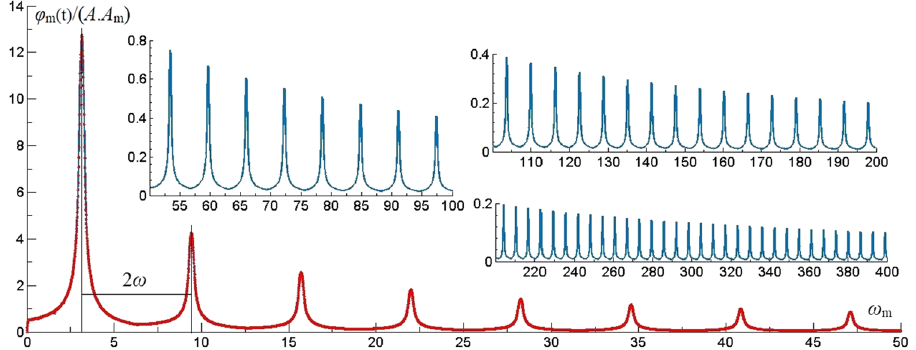
Figure 2. The vibration of φ m (t) of ω m under rectangular wave.